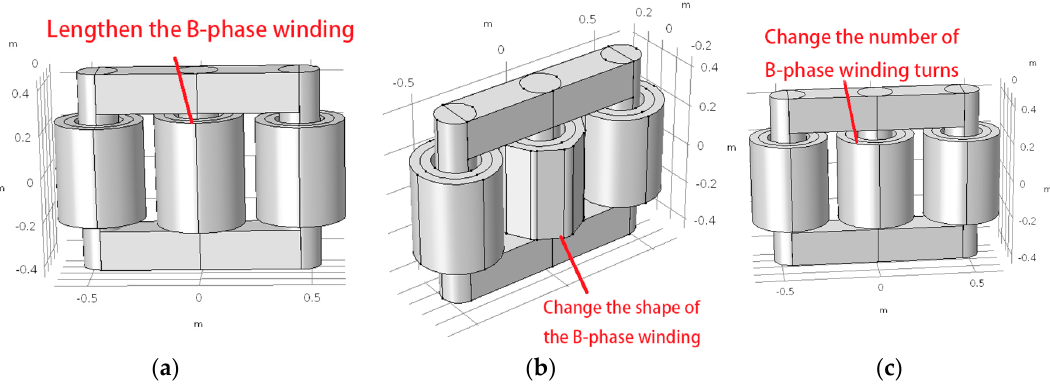
Figure 13. ( a ) Simulation model of winding loosening; ( b ) simulation model of winding-insulation failure; ( c ) simulation model of winding deformation.